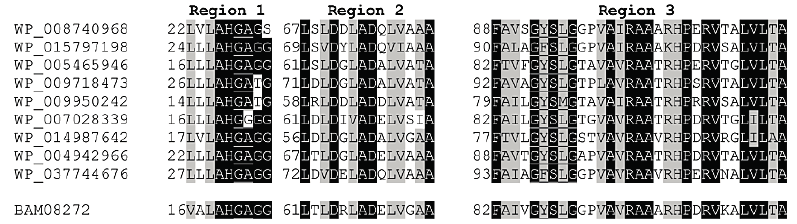
Figure 2. Conserved regions in the HydS14 cluster of putative bacterial lipases. The underlined sequences in region 1 and region 3 correspond to the first oxyanion hole motif and the pentapeptide motif, respectively. The aligned sequences are the representative putative lipases that from the HydS14 cluster: WP_008740968, putative α / β -hydrolase from Streptomyces sp. Mg1; WP_015797198, putative α / β -hydrolase from Catenulispora acidiphila DSM 44928; WP_005465946, putative α / β -hydrolase from Saccharomonospora glauca K62; WP_009718473, putative α / β -hydrolase from Streptomyces himastatinicus ATCC 53653; WP_009950242, putative α / β -hydrolase from S accharopolyspora erythraea NRRL 2338; WP_007028339, putative α / β -hydrolase from Amycolatopsis decaplanina DSM44594; WP_014987642, putative α / β -hydrolase from Nocardia brasiliensis ATCC 700358; WP_004942966, putative α / β -hydrolase from Streptomyces mobaraensis NBRC 13819; and WP_037744676, putative α / β -hydrolase from Streptomyces mirabilis . The alignment was performed using the ClustalW program. Identical amino acids are shown with a black background, whereas a gray background indicates identical or equivalent amino acids.